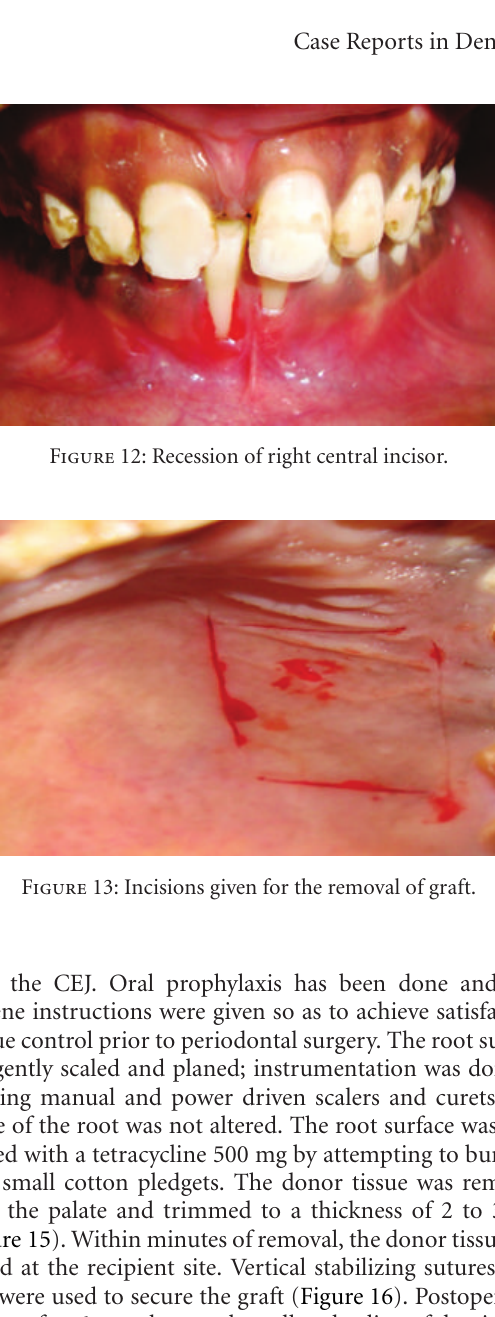
Figure 10: Placement of suture.